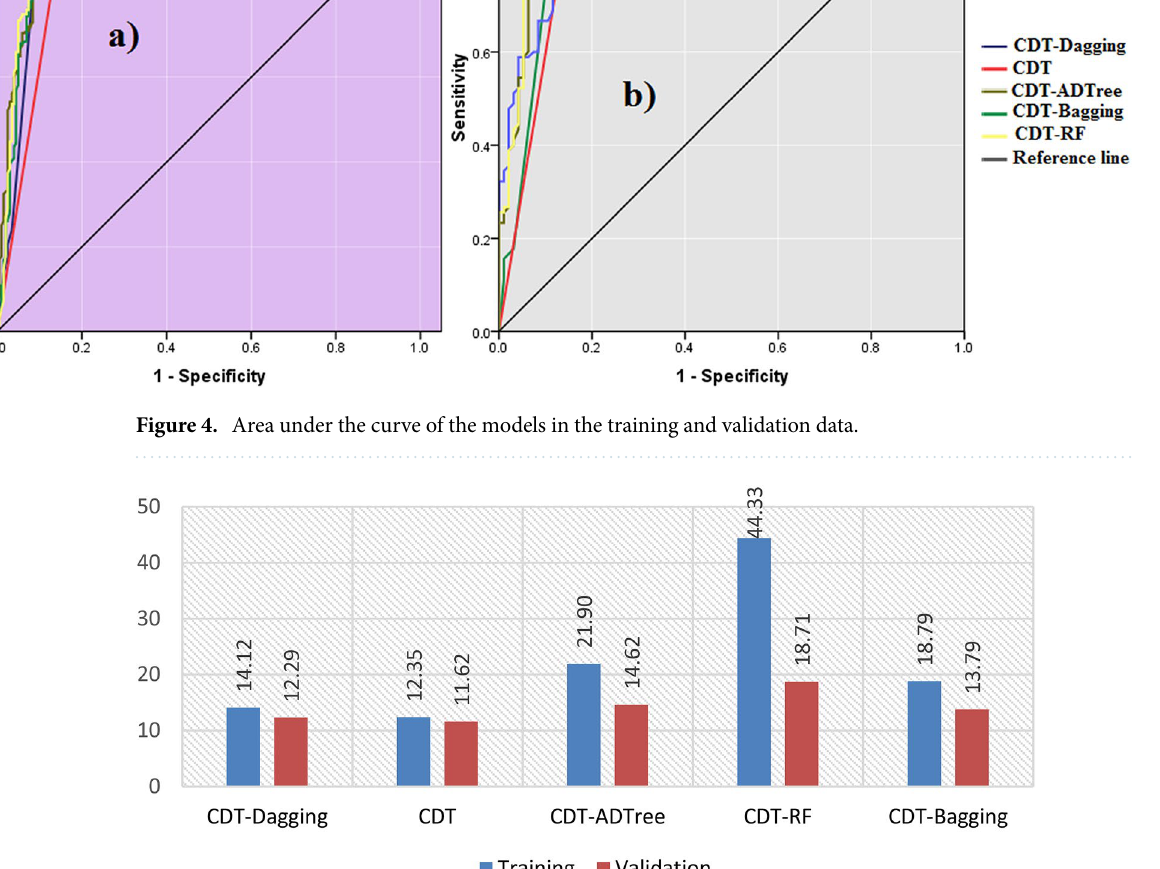
Figure 5. Odd ratio values of the models in the training and validation